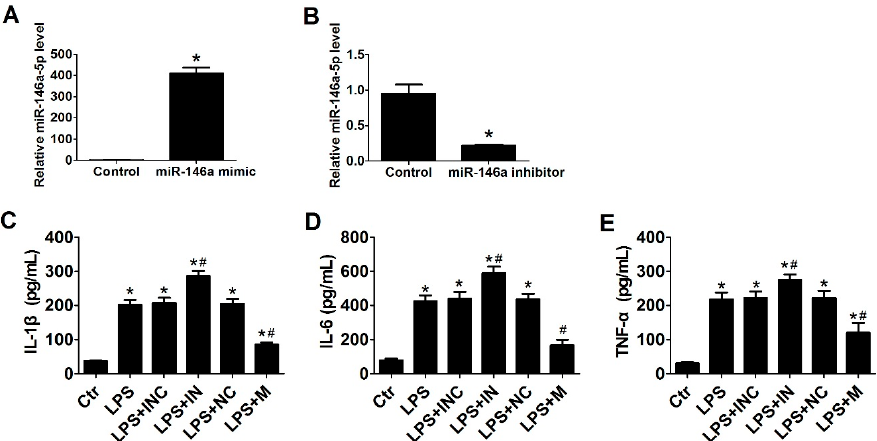
Figure 2. Overexpression of miR-146a-5p reduced the production of interleukin-1 beta (IL-1 β ), IL-6 and TNF- α in LX2 cells. LX2 cells were transfected with miR-146a-5p mimic or inhibitor for 24 h, followed by incubation with LPS (500 ng/mL) for another 24 h. qRT-PCR showed that the expression of miR-146a-5p in LX-2 cells was significantly elevated by miR-146a-5p mimic ( A ) and decreased by miR-146a-5p inhibitor ( B ). The miR-146a-5p mimic control or inhibitor control served as the corresponding negative control. Overexpression of miR-146a-5p inhibited the production of: ( C ) IL-1 β ; ( D ) IL-6; and ( E ) TNF- α in LX2 cells after treatment with 500 ng/mL of LPS for 24 h. * p < 0.05 vs. blank control group; # p < 0.05 vs. the corresponding negative control group. Ctr: blank control; INC: miR-146a-5p inhibitor control; IN: miR-146a-5p inhibitor; NC: miR-146a-5p mimic control; M: miR-146a-5p mimic.